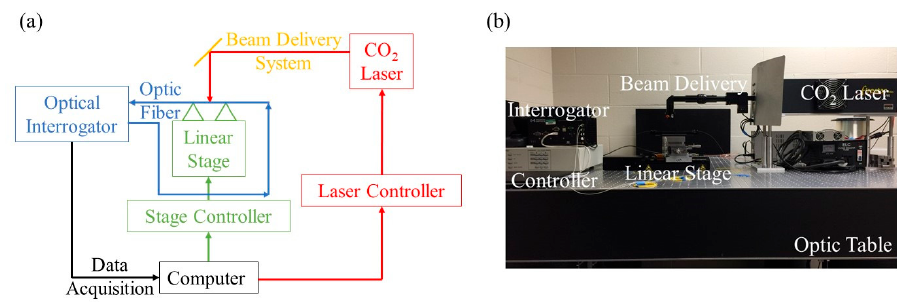
Figure 1. The CO 2 laser grating system: ( a ) schematic view, and ( b ) laboratory setup.